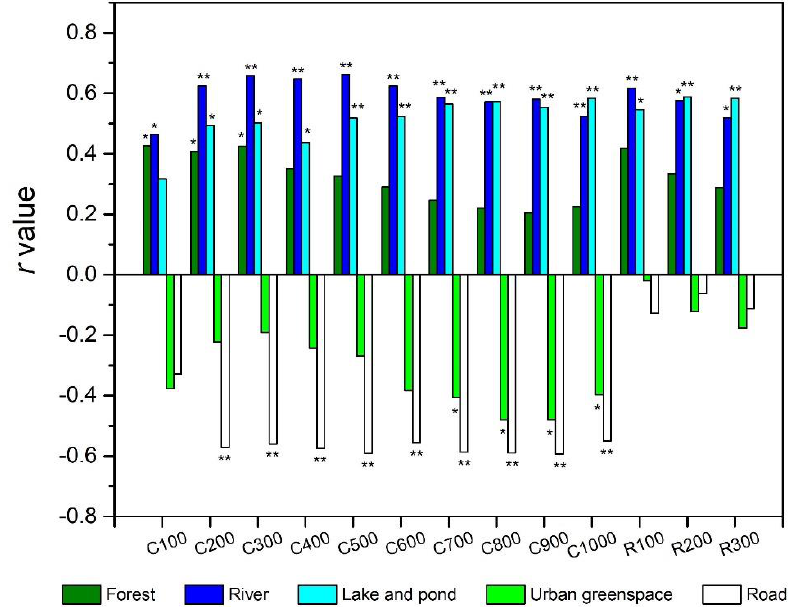
Figure 9. Correlations between Chla Baci-Dino and the areas of particular land use types under the circular and riparian buffering scales at different spatial scales based on a Spearman’s rank correlation analysis. The one-asterisk (two-asterisk) superscripts denote above 90% (95%) confidence levels. Note that only the land uses that significantly correlated with the Chla Baci-Dino were shown.